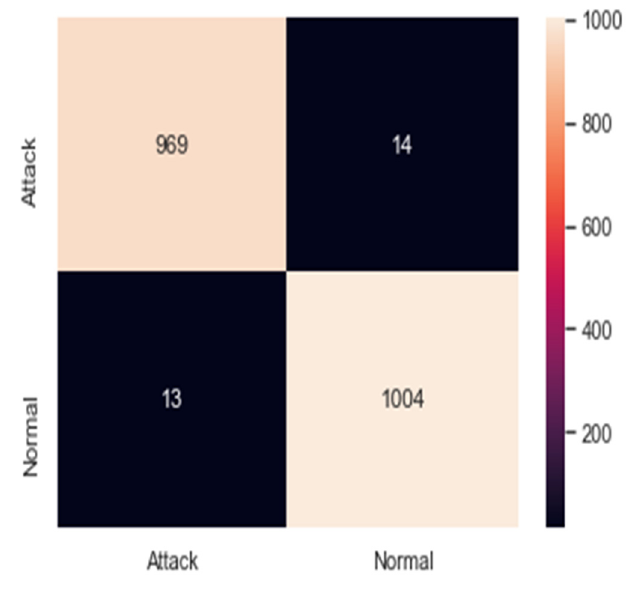
Table 4. DDoS detection results under the BDLSTM-autoencoder model for three different train- test-validate data